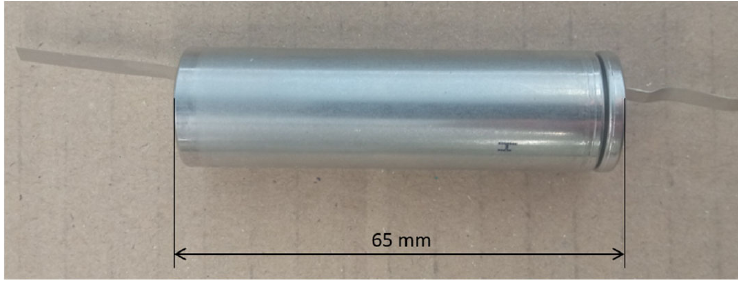
Figure 1. INR18650 MH1 3200 mAh battery